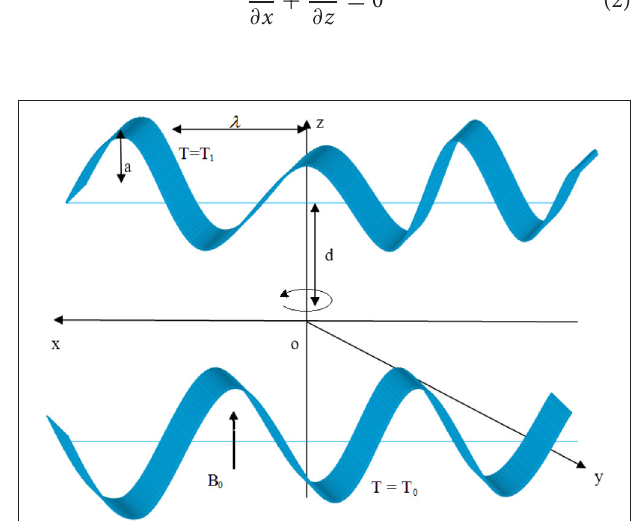
FIGURE 1 | Physical interpretation of the